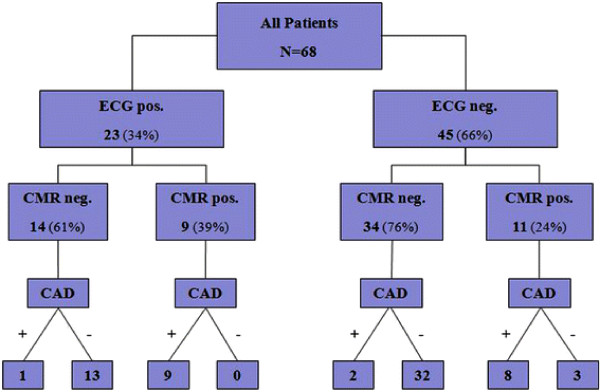
Combined Outcome of Exercise ECG and CMR For the Detection of CAD. ECG = Exercise Electrocardiogram, CMR = Cardiovascular Magnetic Resonance, CAD = Coronary Artery Disease.